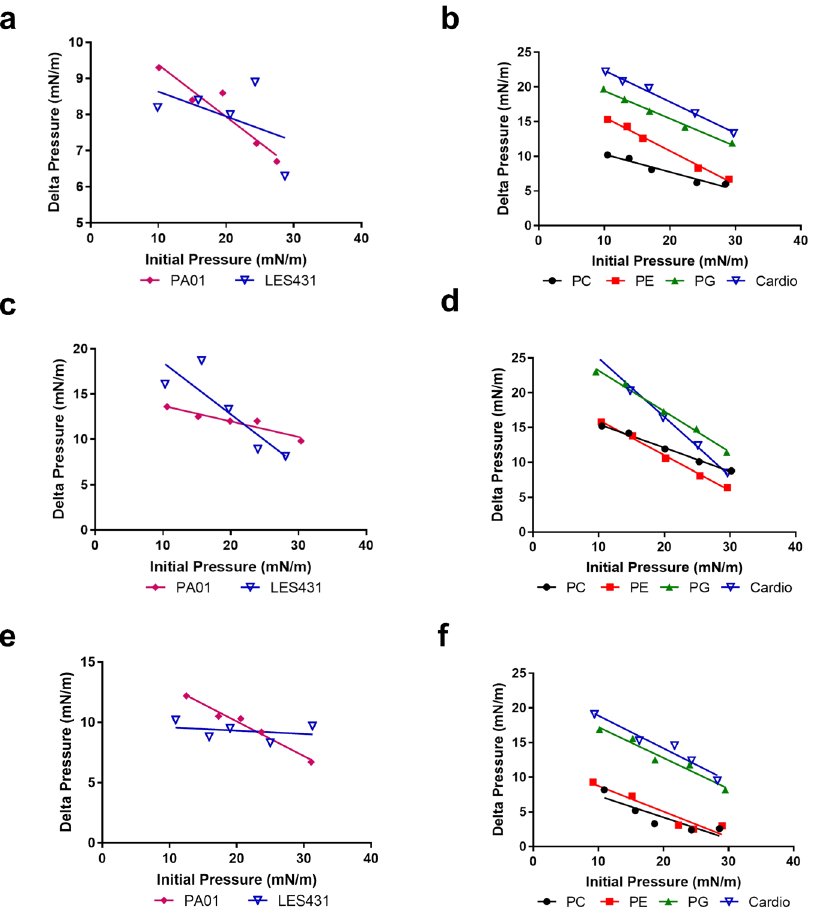
Fig. 4 Peptide – lipid interaction and insertion measurements. Lipid monolayer measurements for the interaction of Lynronne 1, 2 and P15s with total lipid extracts or pure lipids, a interaction of Lynronne 1 with LES431 and PA01 lipid extracts, b interaction of Lynronne 1 with pure lipids, c interaction of Lynronne 2 with LES431 and PA01 lipid extracts, d interaction of Lynronne 2 with pure lipids, e interaction of P15s with LES431 and PA01 lipid extracts, f interaction of P15s with pure lipids. PC 1-palmitoyl-2-oleoyl-glycero-3-phosphocholine, PG 1-palmitoyl-2-